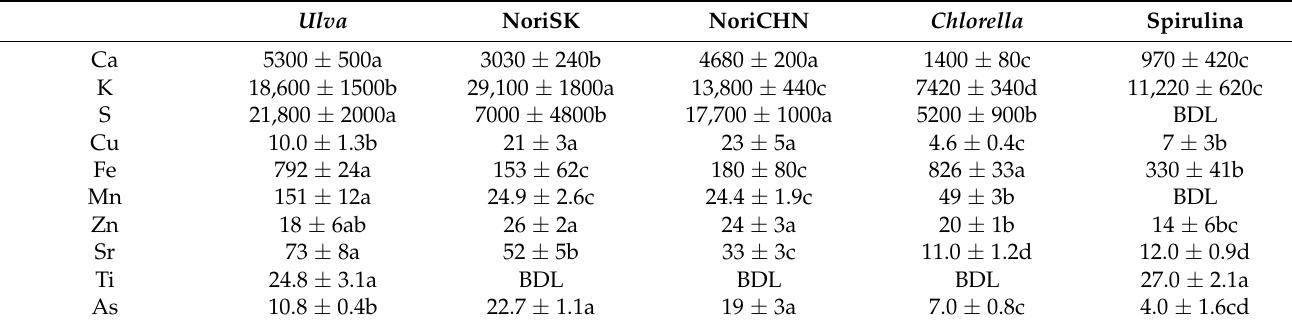
Table 3. Elemental composition of different unicellular ( Chlorella ) and multicellular algae, (Sea lettuce— Ulva sp.; Nori— Porphyra sp.) and the Cyanobacteria Spirulina